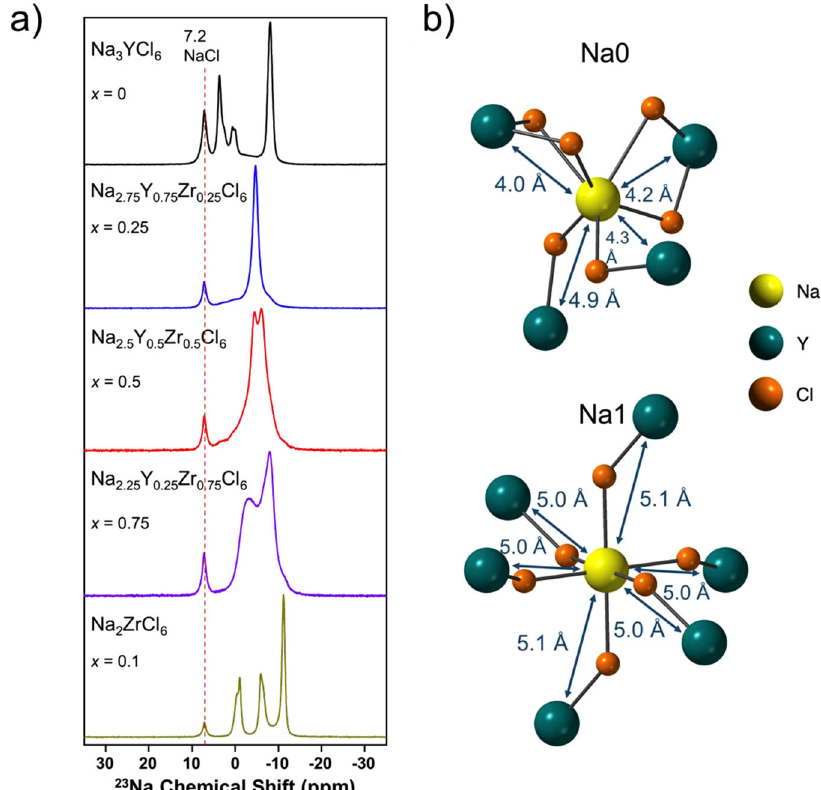
Fig. 3 23 Na single-pulse solid-state NMR spectra. a Spectra collected on Na 3- x Y 1- x Zr x Cl 6 ( x = 0, 0.25, 0.5, 0.75 and 1); the data were acquired at 18.8 T and at a MAS rate of 12 kHz and at a set temperature of 298 K. b Schematic of the Na0 and Na1 local environments in Na 3 YCl 6